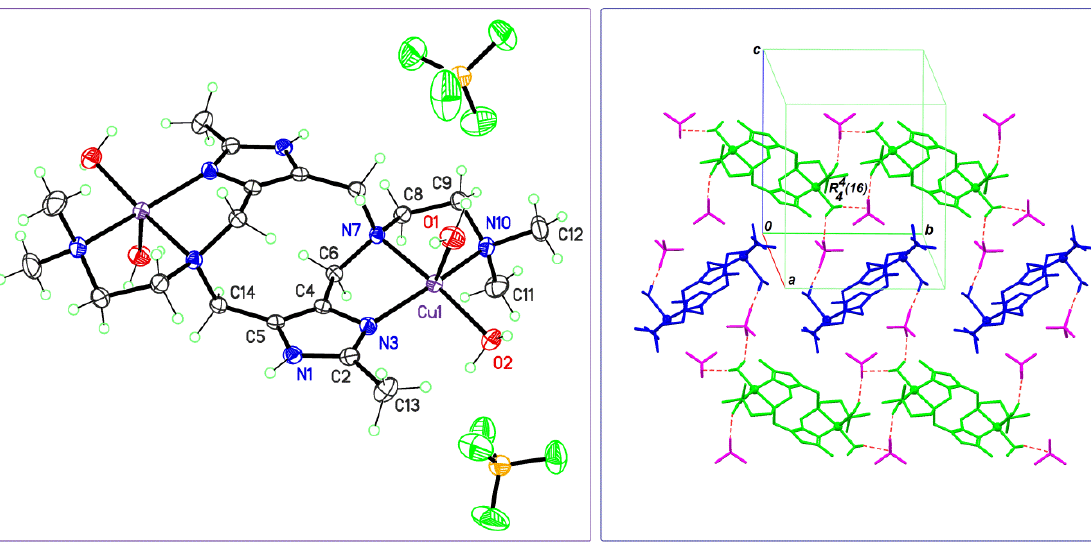
Figure 2. Left: ORTEP -like view of one cation and two anions in complex 1 ; Right: Part of the crystal structure of 1 . Green and blue cations are based on Cu1 and Cu2, respectively. Dashed bonds represent the strongest hydrogen bonds formed between the coordinated − ions (see Table water molecules and the BF 4